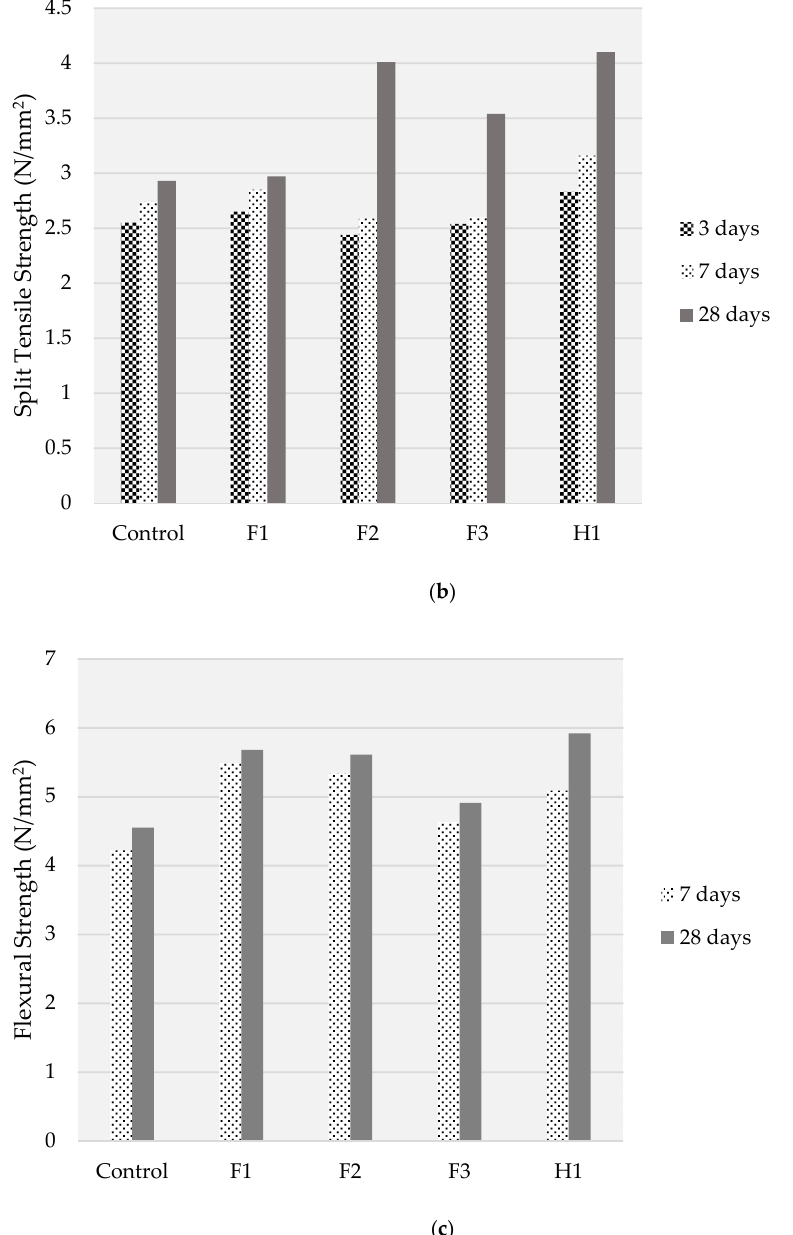
Figure 6. Average experimental results of the different specimen samples. ( a ) Compressive strength variation of samples in N/mm 2 . ( b ) Split tensile strength variation of samples in N/mm 2 . ( c ) Flexural strength variation of samples in N/mm 2 .